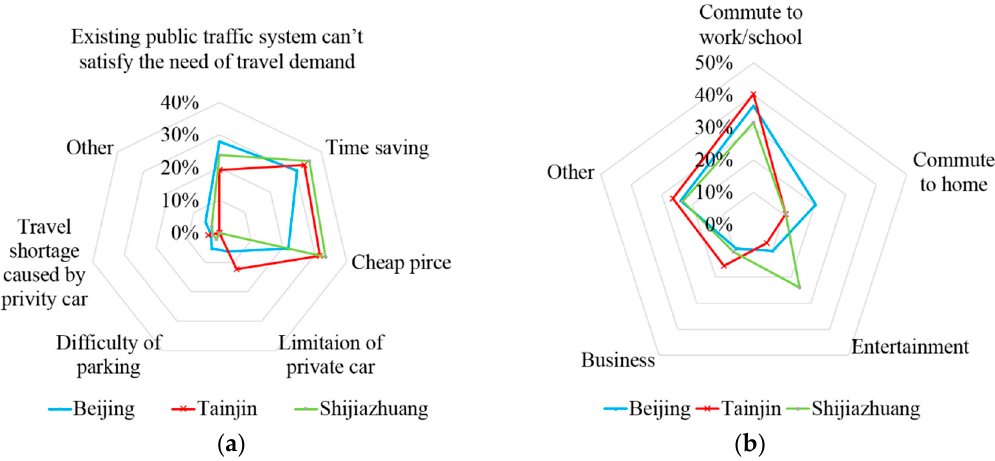
Figure 6. The reason and purpose that users choose DIDI’s ridesharing service. Multiple panels: ( a ) Reason for choosing the DIDI travel service; ( b ) Purpose for using the DIDI travel service.